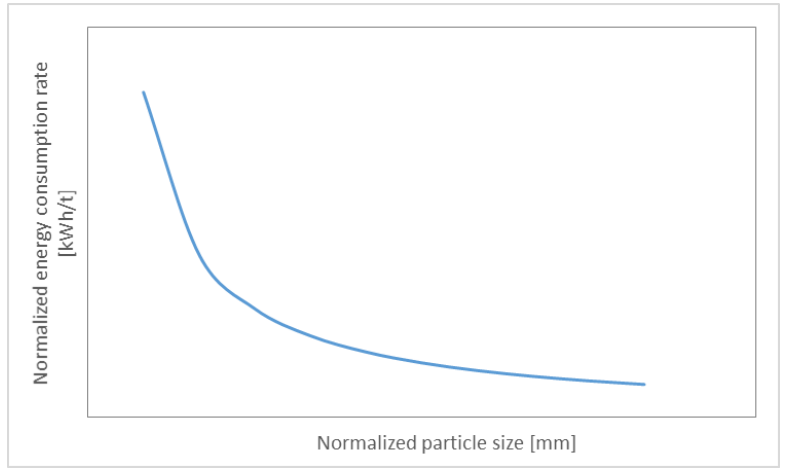
Figure 2. Relationship between energy usage for breaking and the size of treated